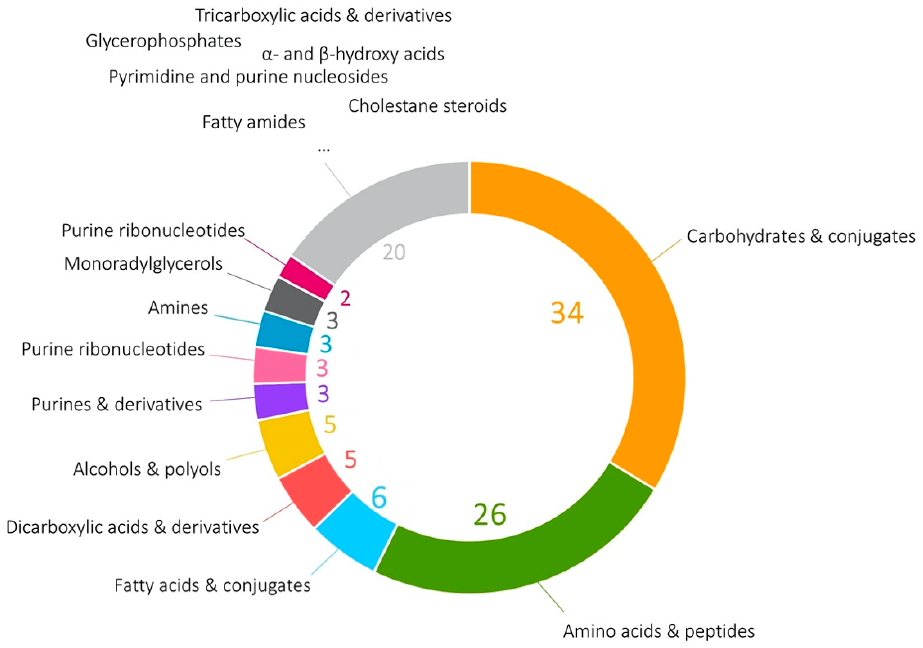
Figure 1. Groups of detected HepG2 metabolites according to HMDB classification. The numbers display the quantity of the discovered metabolites belonging to a certain class.